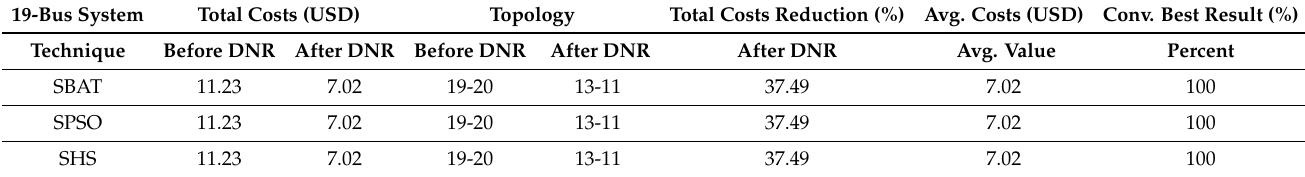
Table 10. Results found for the 19-bus and 20-branch balanced system (variable demand).